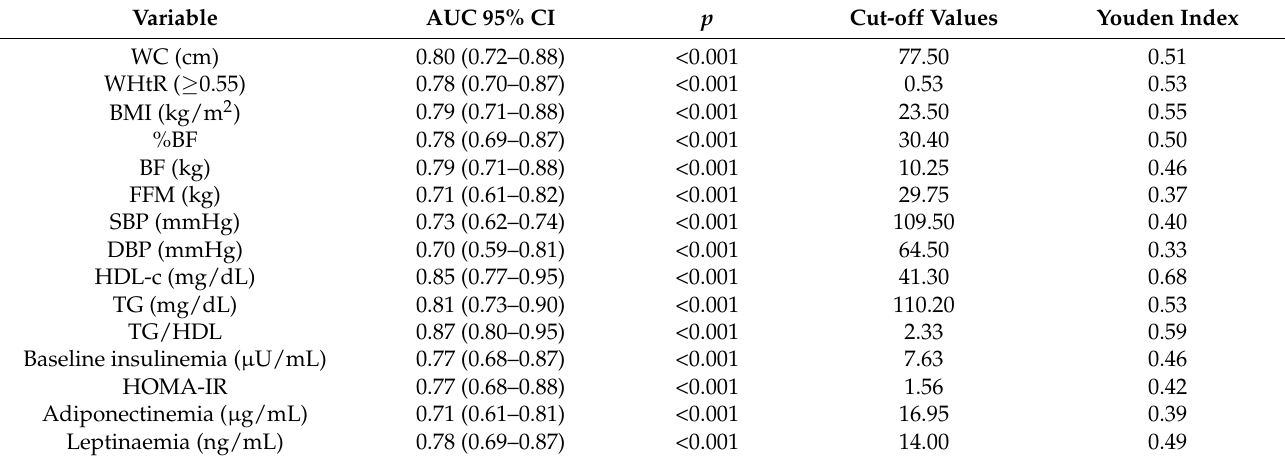
Table 3. Discriminant capacity and MetS diagnostic accuracy for the study